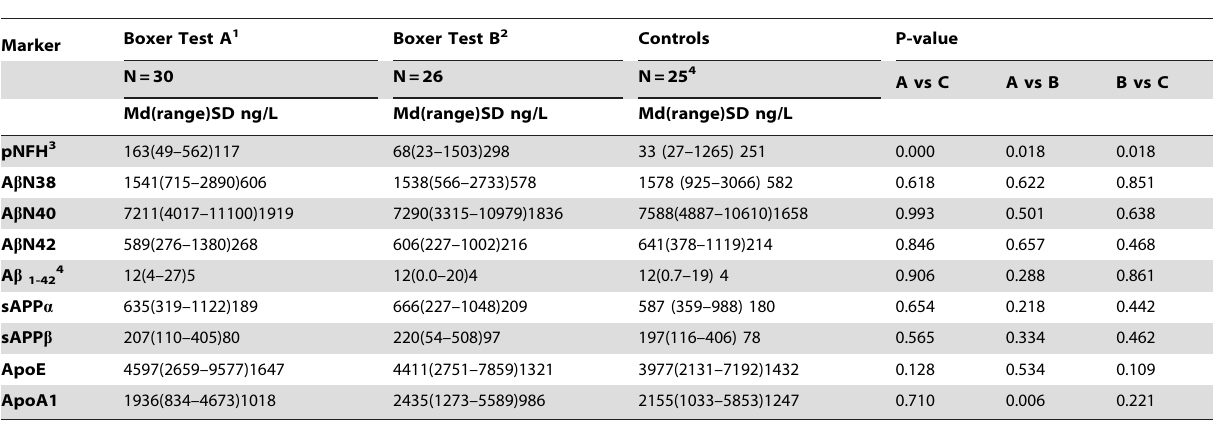
Table 1. Biomarker concentrations in cerebrospinal fluid and plasma. 4